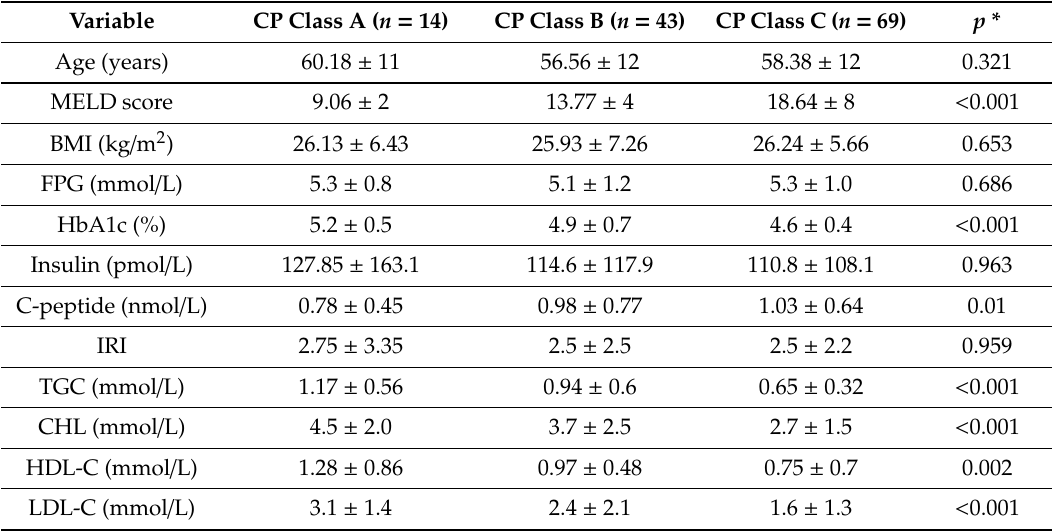
Table 4. Metabolic characteristics of the patients according to stage of liver